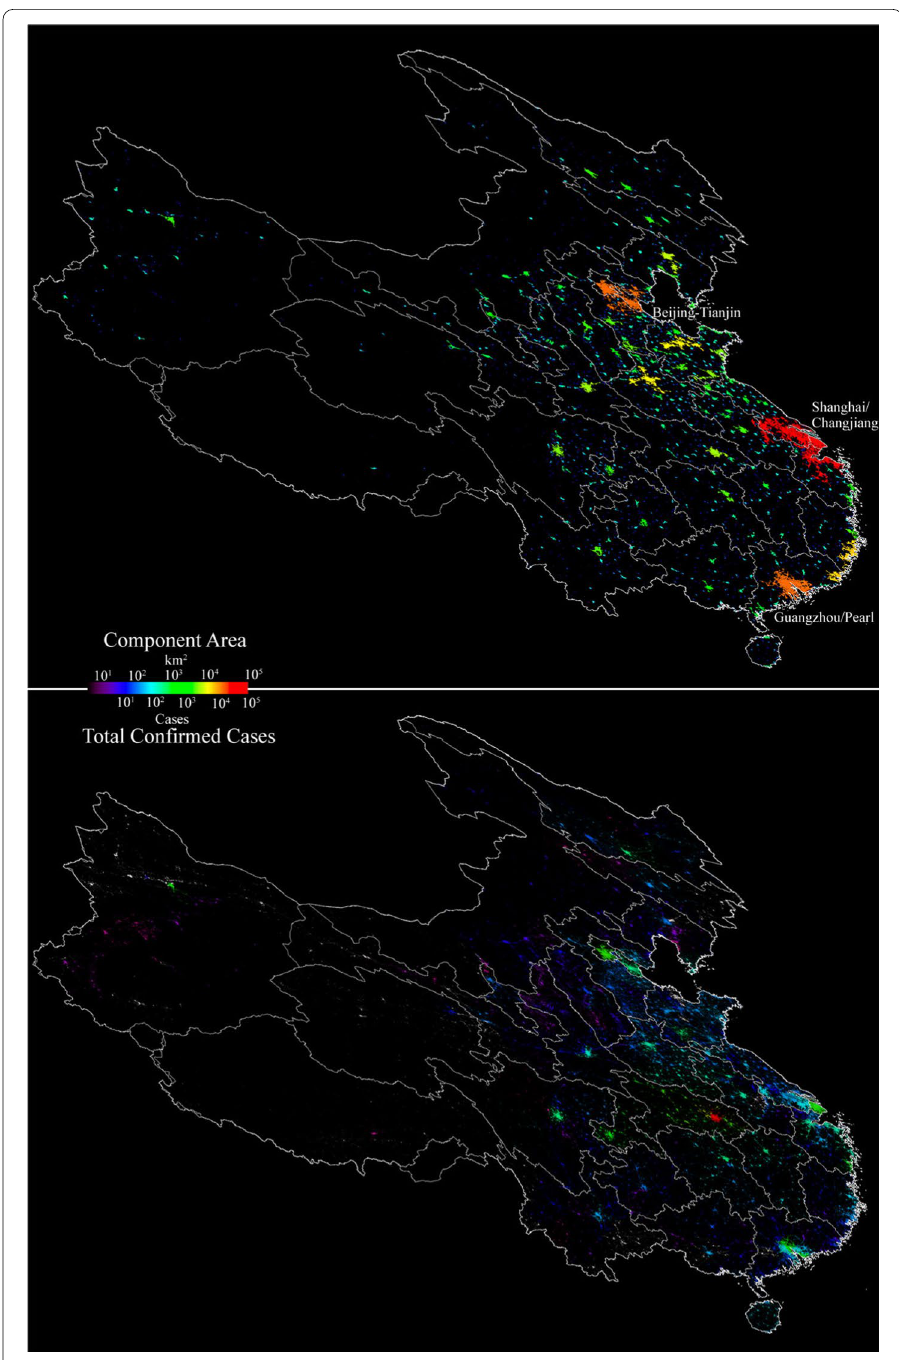
Fig. 4 Network component area map and total confirmed case distribution for China. At this scale, the large number of smaller components with fewer cases are not resolved. As expected, the largest number of cases is in Wuhan, while the surrounding smaller components in Hubei have comparable numbers of cases to the high density cores of the much larger components. Enlarge to see